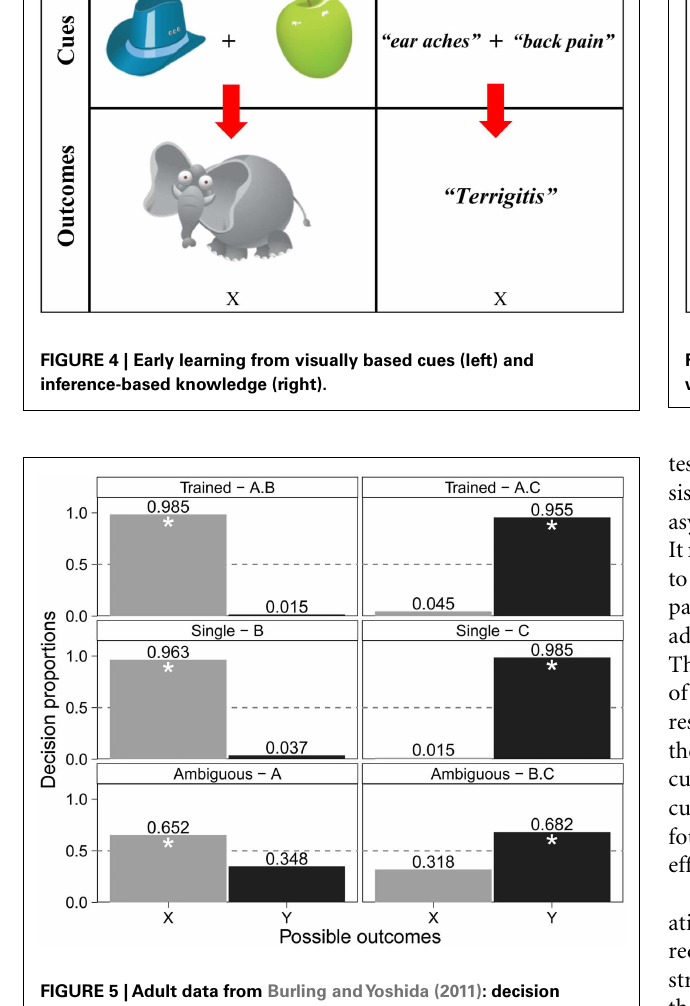
FIGURE 5 |Adult data from Burling andYoshida (2011): decision proportions for possible outcomes (X,Y) given predictive cues (A, B, C) with the asterisks identifying reliably above chance ( p < 0.05).